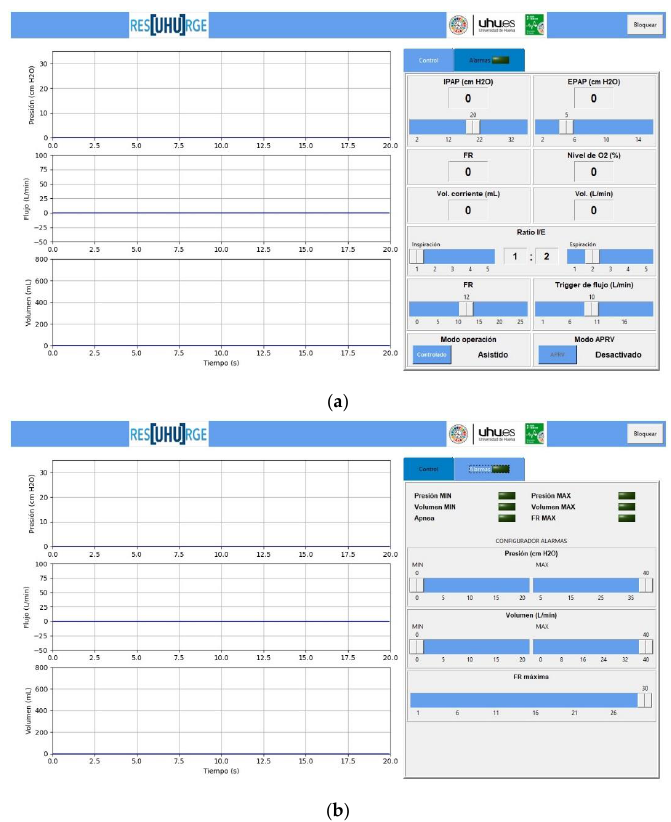
Figure 9. GUI of the developed ventilator. ( a ) Control panel; ( b ) alarm